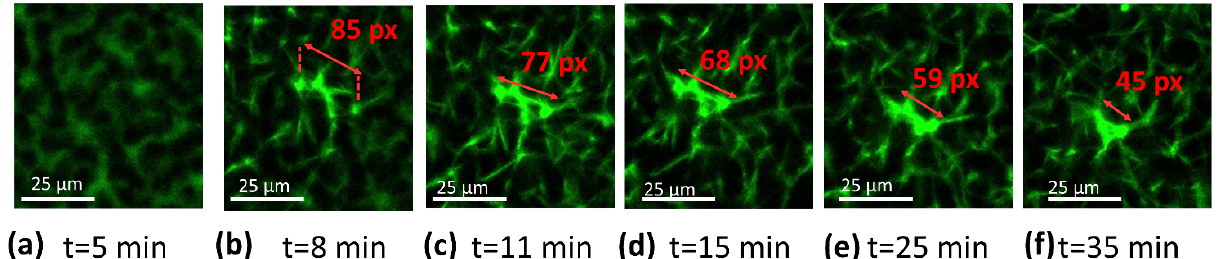
Figure 6. ( a – f ) Detail of a fibrin branch from its appearance at different moments of the contraction. In each frame, the length of fibrin was measured in pixels using ImageJ ® software.